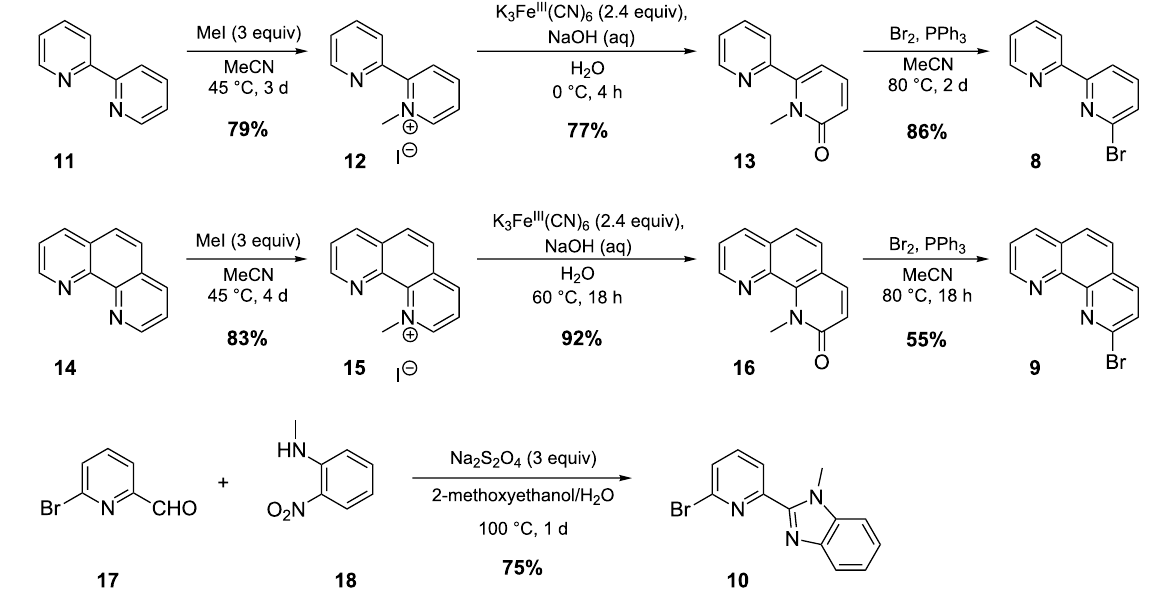
Scheme 4: Synthesis of the heteroaryl bromides used in the coupling reaction.